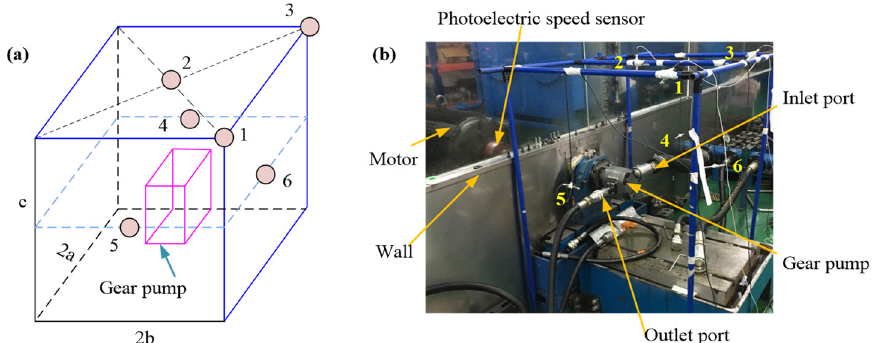
Figure 6. Test rig used for noise measurement. ( a ) Acoustic sensor layout, ( b ) test site.